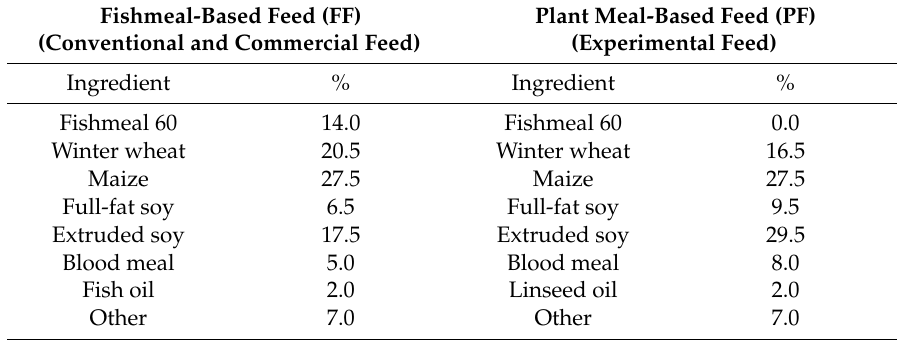
Figure 1. The experimental design at the site of the National Agricultural Research and Innovation Centre, Research Institute for Fisheries and Aquaculture (NAIK HAKI); CT—Control; FF—Fishmeal- based feed; PF—Plant meal-based feed. Table 1. The ingredients of the experimental and conventional, commercial